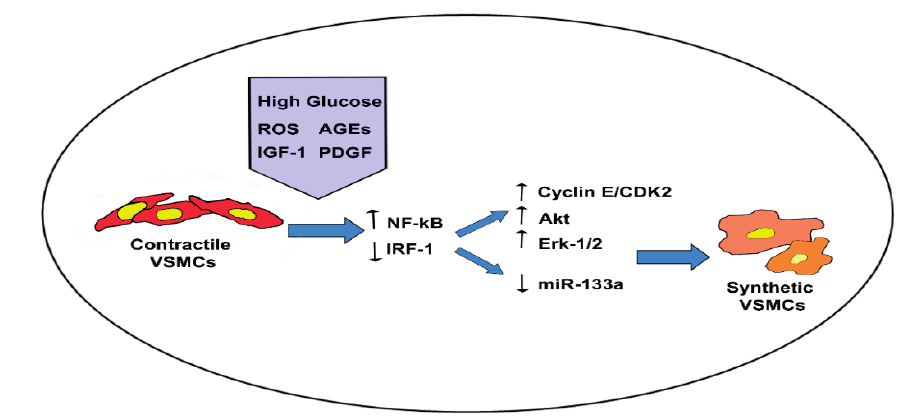
Figure 2. Phenotypic switch of VSMCs in diabetic aortopathy. Schematic representation of diabetes-related intracellular signaling involved in the switch from contractile to synthetic phenotype of vascular smooth muscle cells (VSMCs) in great